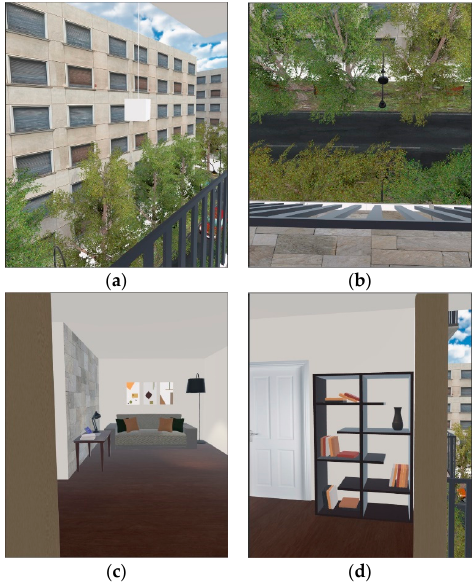
Figure 3. ( a–d ) The Virtual Reality environment used in both systems.